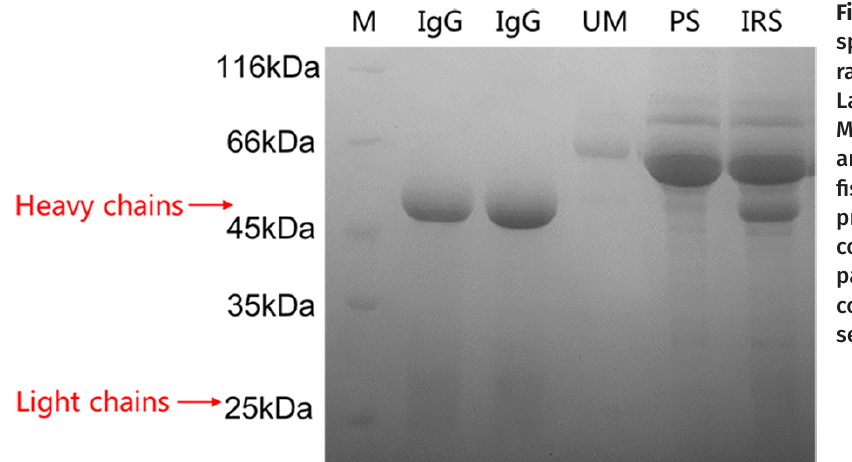
Figure 3. Identification of specific IgG anti-fish IgMs in rabbit serum by SDS-PAGE. Lanes from left to right were MW marker (M), specific IgG anti-fish IgM, specific IgG anti- fish IgM, non-specific binding proteins to rProtein A in packed column, immunized rabbit serum pass through the column and collected, immunized rabbit serum before